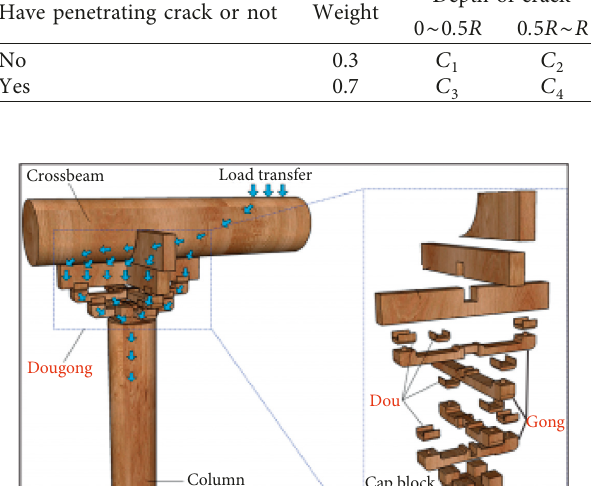
Table 4: Quantification for index x